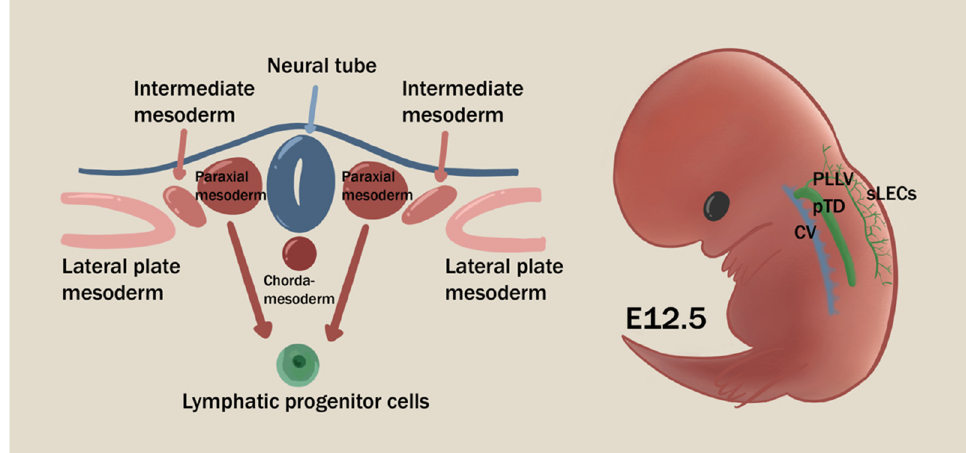
Figure 1. The origin of lymphatic progenitor cells and physiological lymphagiogenesis process at E12.5. Paraxial mesoderm is considered as the major source of lymphatic endothelium at E12.5. The accumulation of initial LECs first sprouts from cardinal vein (CV), then extends dorsally and lumenizes as primordial thoracic duct (pTD) and peripheral longitudinal lymphatic vessels (PLLVs). pTD is connected with the cranial end of PLLVs and develops towards the anatomically mature thoracic duct. PLLVs further branch off as a smaller structure of continuous LEC layer (sLECs).